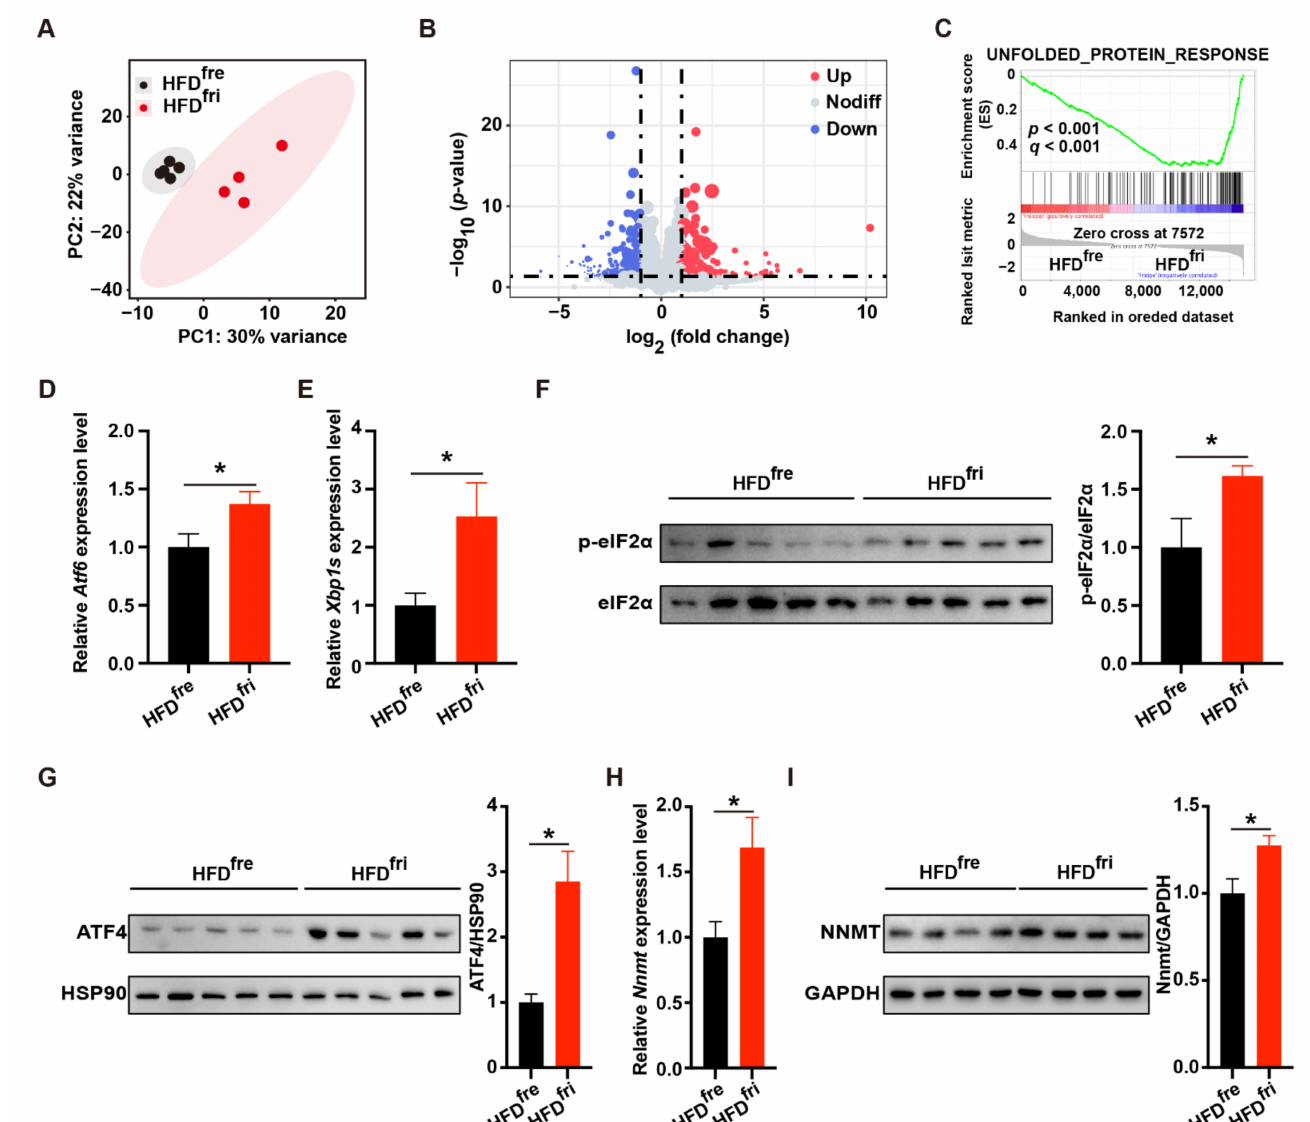
Figure 4. Elevation of unfolded protein response (UPR) in the mice fed by high-fat diets (HFDs) stored in the fridge (fri) (HFD fri ). ( A – C ) RNA-seq analysis of the liver including ( A ) principal component analysis (PCA), ( B ) volcano plot, and ( C ) gene set enrichment analysis (GSEA) results of unfolded protein response (UPR)-related gene set (high-fat diet (HFD) stored in the freezer (fre) (HFD fre ), n =